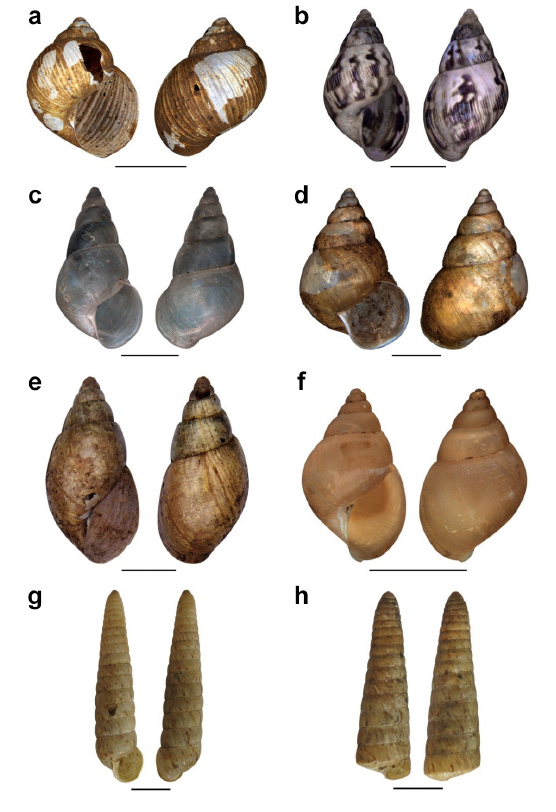
Figure 6. Shell in different views. a. Simpulopsis sulculosa (CMIOC 11173), b. Drymaeus papyraceus (CMIOC 11148), c. Leiostracus perlucidus (CMIOC 11154), d. Rhinus ciliatus (CMIOC 11163), e. Lopesianus crenulatus (CMIOC 11159), f. Bulimulus tenuissimus (CMIOC 11123), g-h. Megaspira elatior adult (g) and younger (h) (CMIOC 11161). Scale: 1